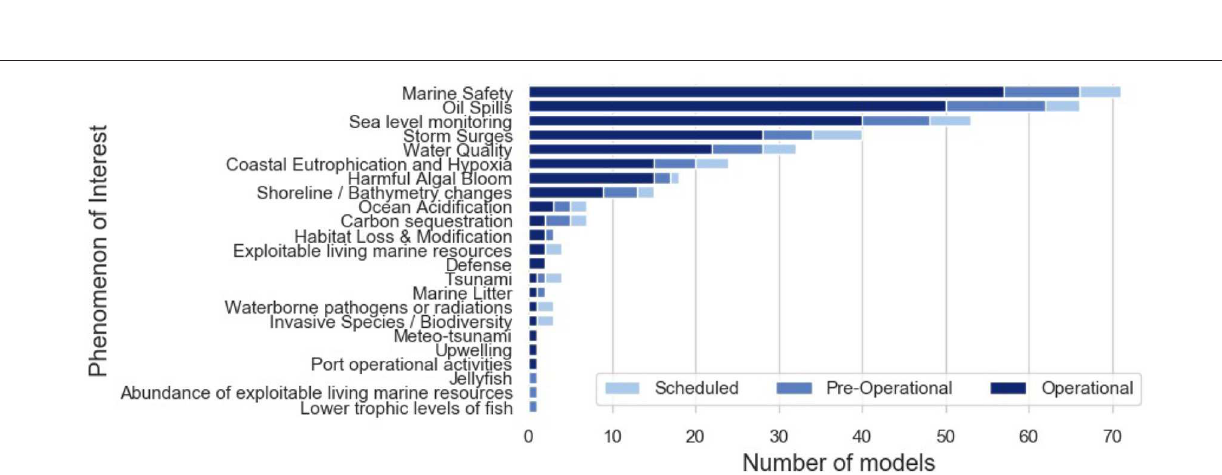
Frontiers in Marine Science |